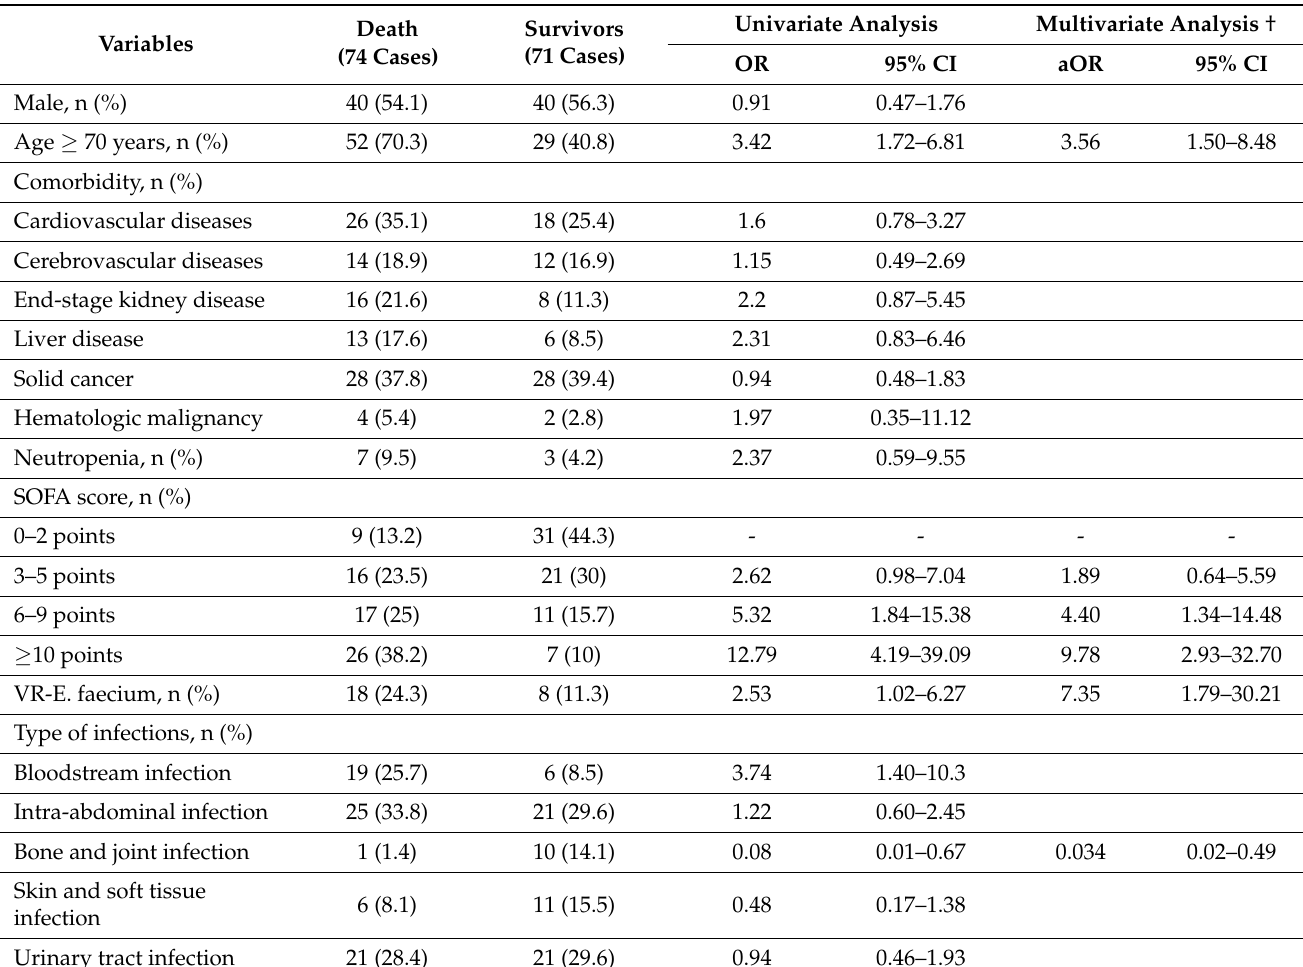
Table 3. Factors predicting 90-day mortality among patients with Enterococcus faecium infections by univariate and multivariate